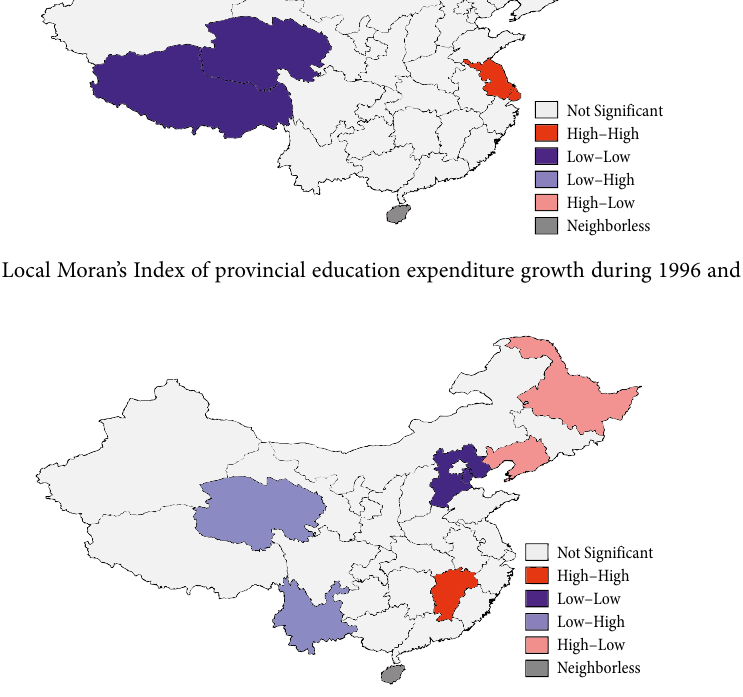
Fig. 4. The Local Moran’s Index of provincial education expenditure growth during 2001 and